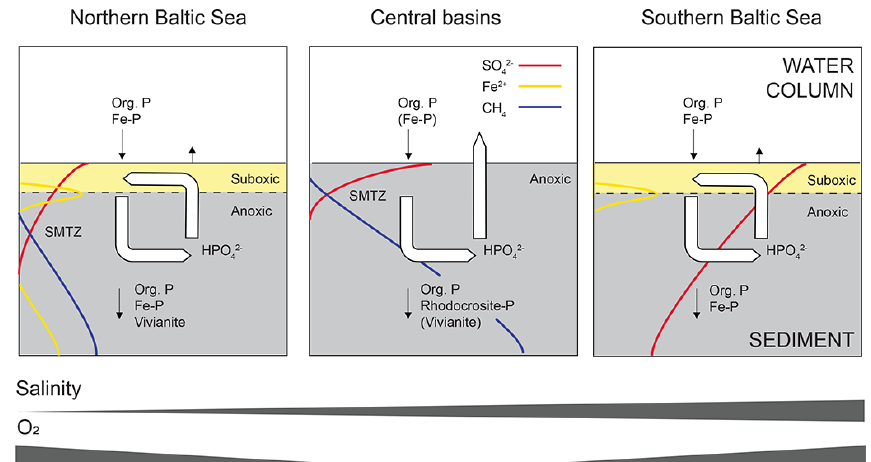
Figure 7. Schematic of vertical biogeochemical zonation of Baltic Sea sediments from a perspective of P cycling (partially redrawn from Lehtoranta et al., 2009). Coloured lines indicate pore water concentrations of key species (zero to left). In areas with oxic bottom waters, remineralization of OM in the suboxic zone proceeds by denitrification and metal oxide reduction. Remineralization proceeds by sulfate reduction and methanogenesis in the anoxic zone, above and below the sulfate–methane transition zone (SMTZ), respectively. Processes impacting on regeneration and burial of P are shown with annotated arrows. Remineralization produces orthophosphate (HPO 2 − may diffuse to the bottom waters, become trapped in surface–sediment Fe oxides, or incorporated into authigenic minerals, depending on the depositional environment (see text). Note that exceptions to these schematic representations can occur (e.g., Brodecka et al., 2013, observed a shallow SMTZ in the Gdansk Basin in the southern Baltic Sea, due to high rates of C org deposition and sulfate